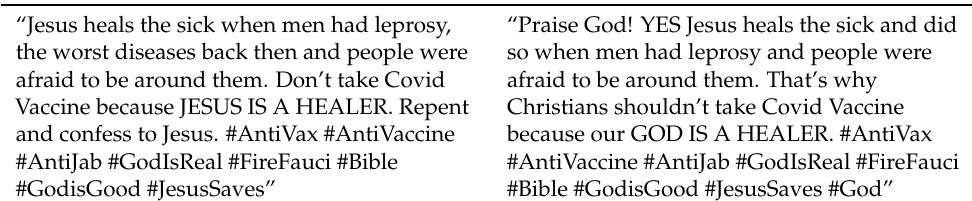
Table 8. Tweets of @WavesofGo account that indicate the account was a strong supporter of Christianity and was against